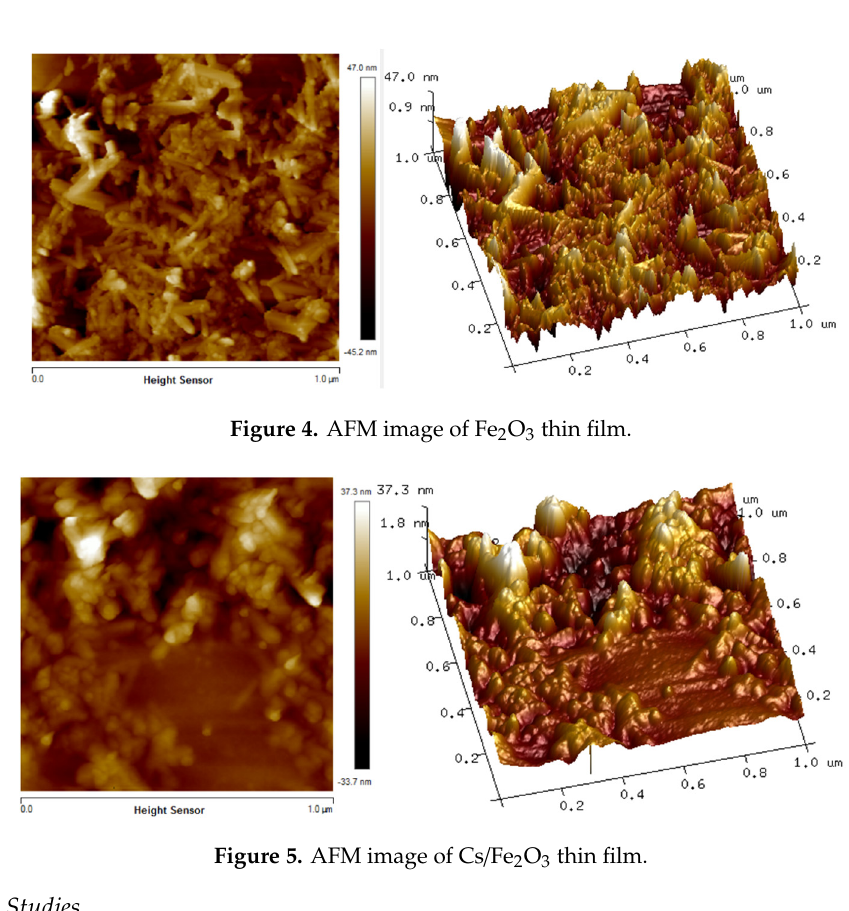
Figure 5. AFM image of Cs/Fe 2 O 3 thin film.